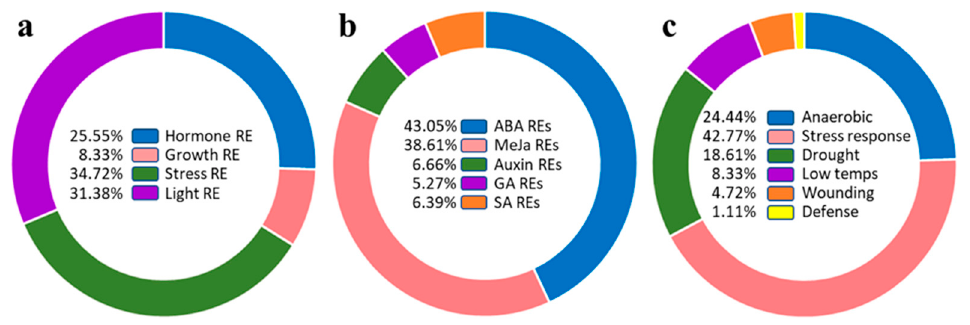
Figure 5. Classification of putative cis -regulatory elements present in the upstream region of TdSULTR genes ( a ), involved in response to phytohormones ( b ), and stresses ( c ). Full details are provided in Table S3.